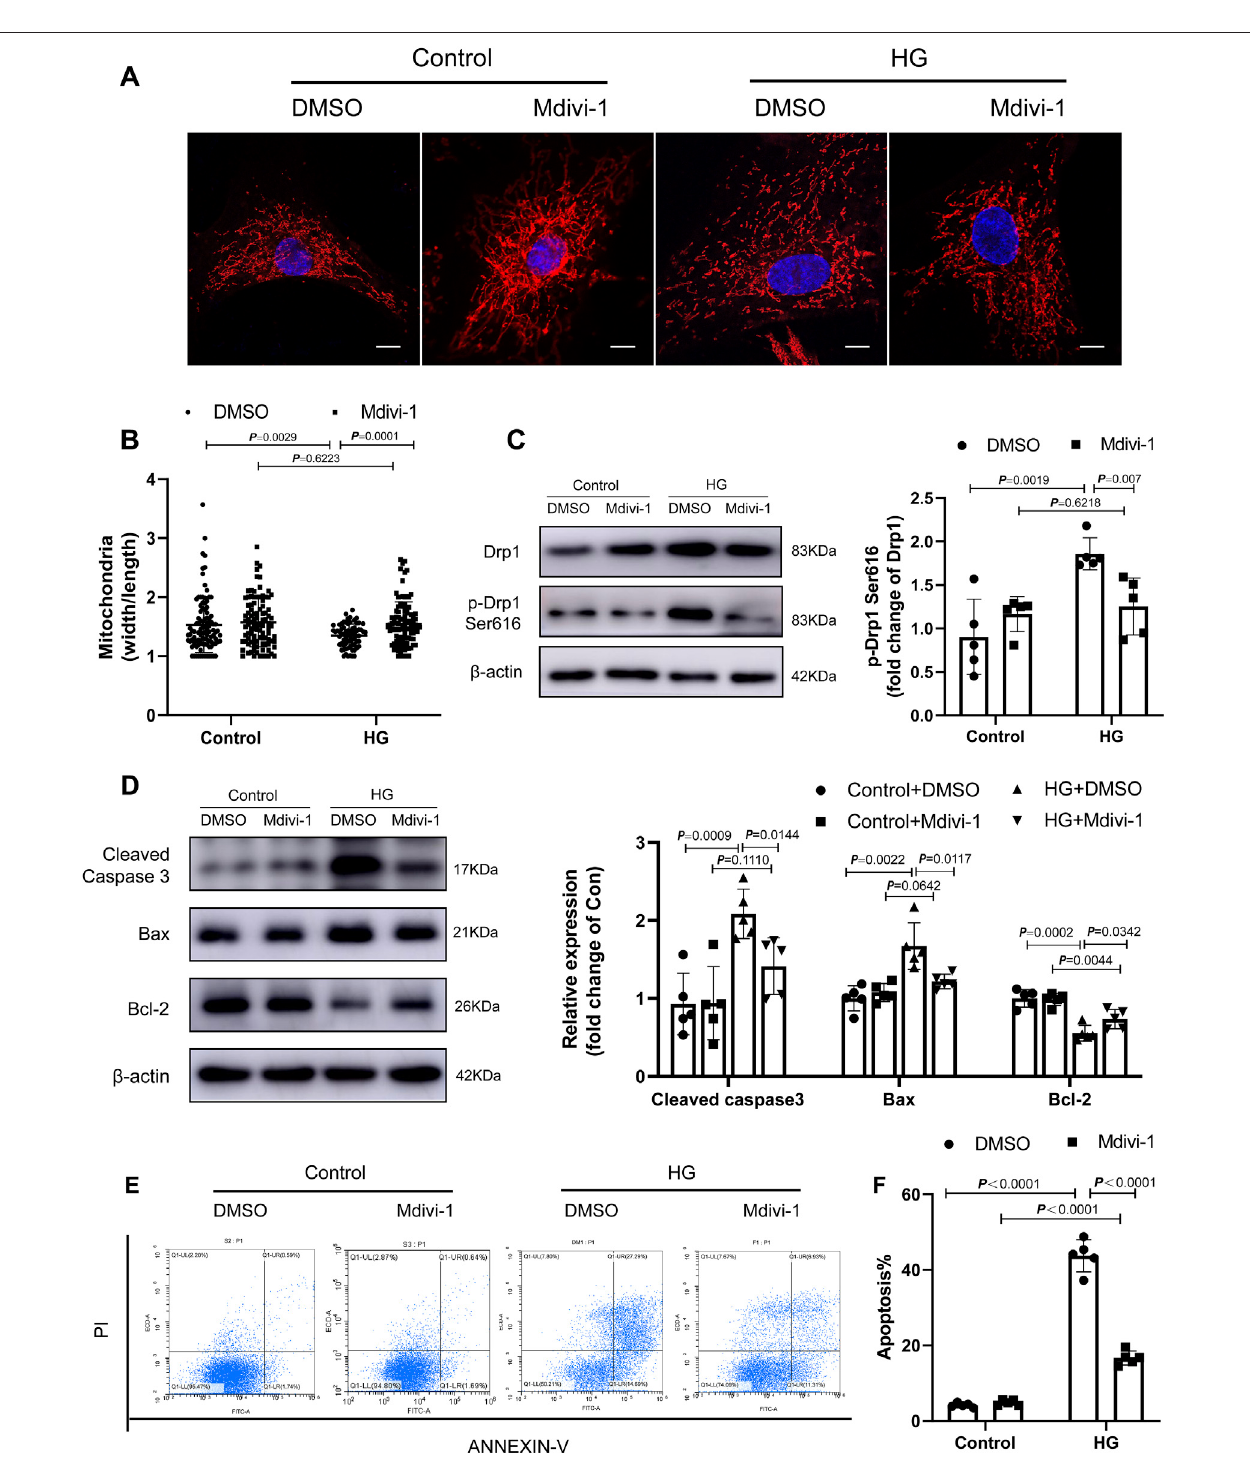
FIGURE 7 | Fasudil ameliorated cardiomyocyte apoptosis induced by hyperglycemia and hyperinsulinemia in vitro . (A,B) NMCMs were treated with HG (33 mM and 10 nmol/L insulin)and stainedusing Mitotracker Red and DAPI(n =3). Confocal laserscanning fl uorescence microscope imagingofthe mitochondrial morphology. Mitochondrial fi ssion was evaluated by the ratio of mitochondrial length and width, which was plotted for thousands of mitochondria from > 10 cells. Scale bar = 20 μ m (C) levelsofDrp1phosphorylatedatserine616inNMCMsunder48 hperiodsofHGstimulationandMdivi-1treatment(n=5) (D) Representativeimmunoblotsand quanti fi cation of Cleaved Caspase3, Bax and Bcl-2 in NMCMs under 48 h periods of HG stimulation and Mdivi-1 treatment ( n = 5) (E,F) Apoptosis detection and quantitative analysis via Annexin V/PI staining of cardiomyocytes in HG conditions or Mdivi-1 treatment for 48 h (n = 5). p -values were adjusted for comparisons of multiple